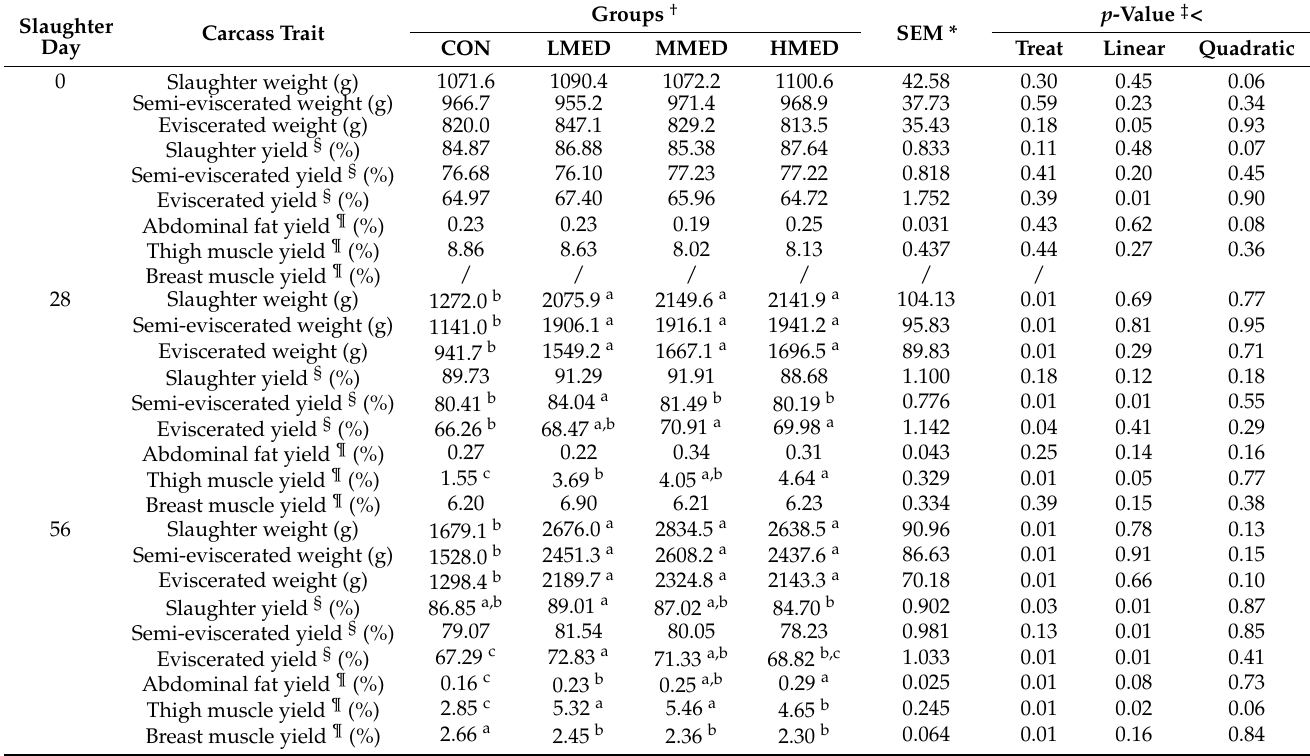
Table 4. Effects of supplemental feeding of three levels of metabolizable energy (ME) on carcass traits of grazing Swan geese. Slaughter Day